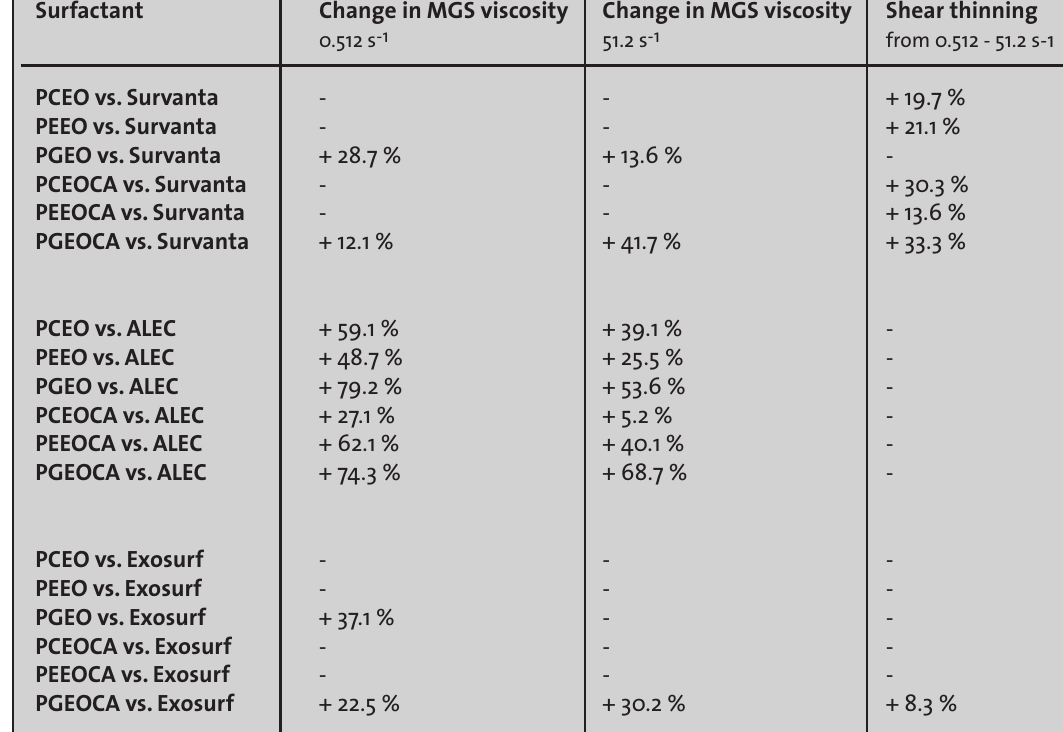
Table 2: Comparison of rheological aspects of surfactants (with eucalyptus with or without calcium) and therapeutic